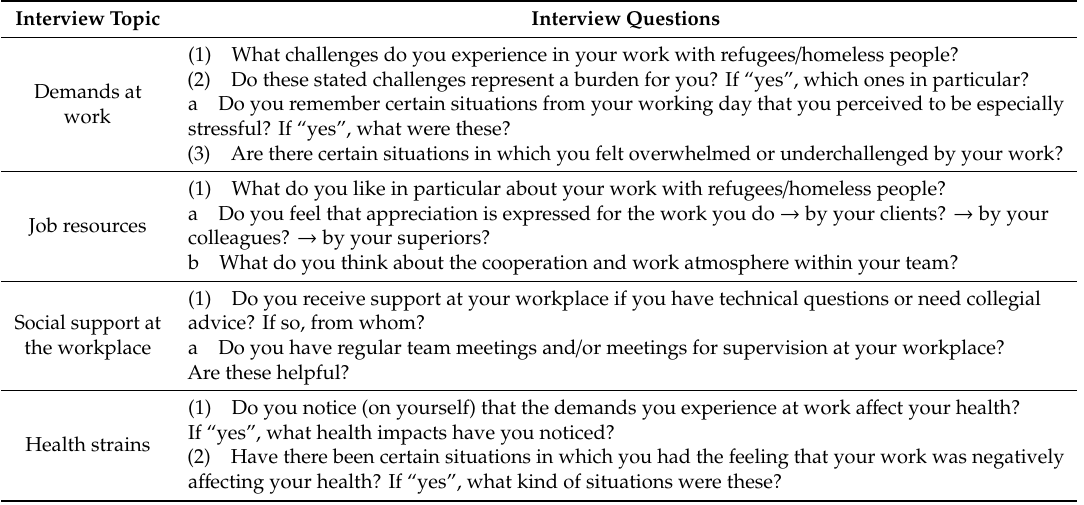
Table A1. Extract of relevant topics and questions from the interview